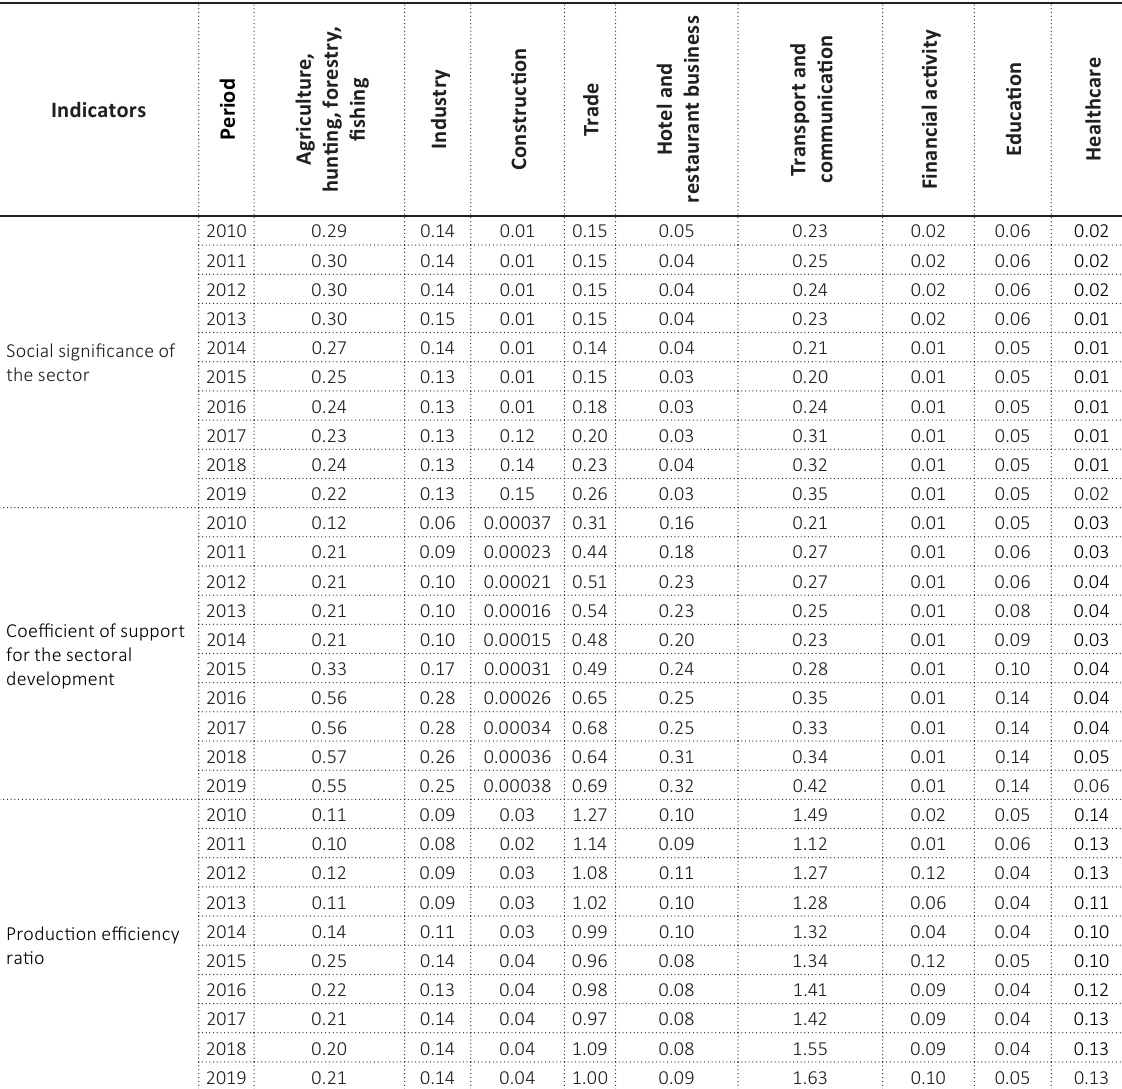
Table 1. Investment attractiveness indicators